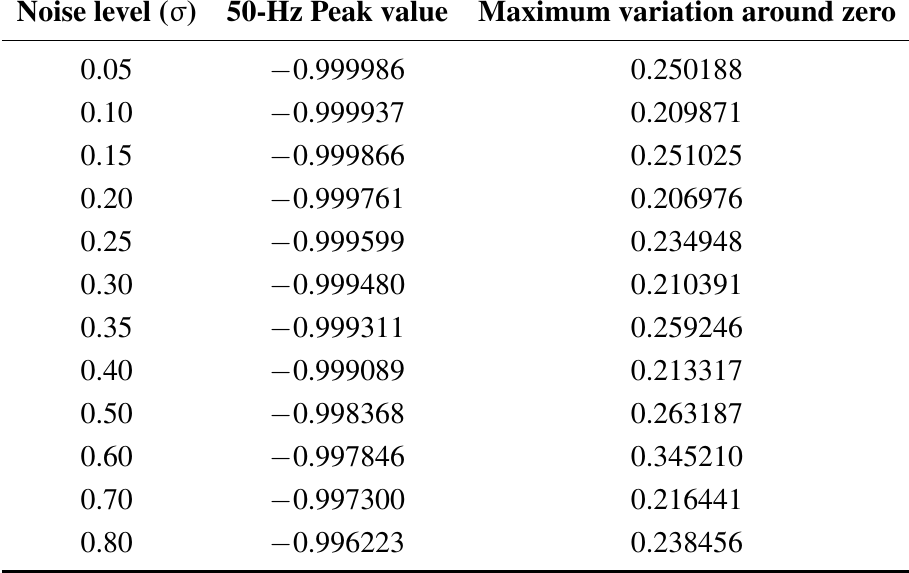
Table 1. SK analysis results for a healthy signal with different noise contamination